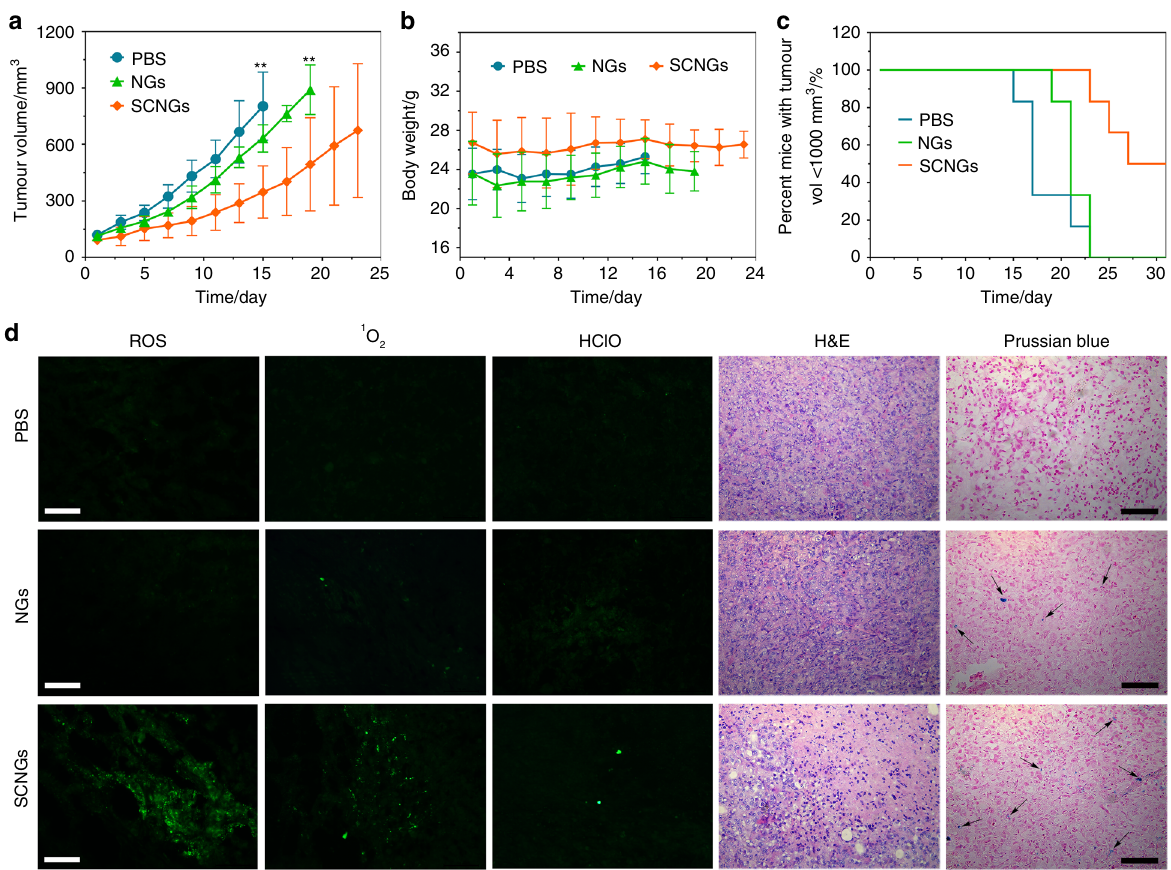
Fig. 7 In vivo EDT on HCC PDX mouse model. The relative tumour volume ( a ), body weight ( b ) change curves and the corresponding survival percentages ( c ) of each group of mice. Dose: PBS (100 μ L), NGs and SCNGs (100 μ L, 5 mg mL − 1 ). Date are the means ± s.d. ( n = 6). p values were analyzed by Student ’ s two-sided t -test (** P < 0.01). d Histopathology analysis of the HCC PDX tumour tissue: ROS, 1 O 2 , HClO, H&E and Prussian blue staining, respectively. Scale bar, 100 μ m. Source data are provided as a Source Data fi